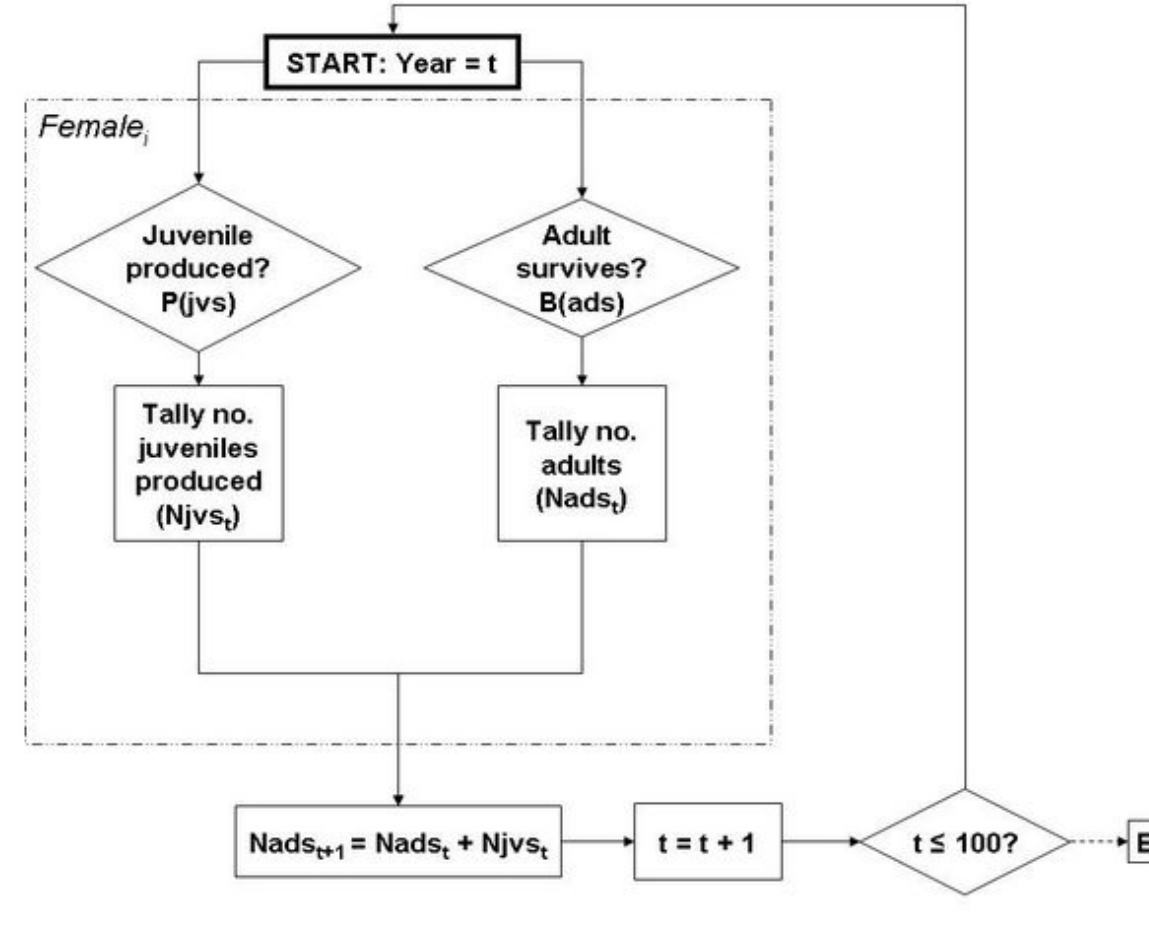
Fig. 1. Flow diagram showing algorithm used for each iteration in stochastic, female-focused, stage- based, discrete population viability analysis for large-bodied woodpeckers. Probabilities are abbreviated as follows: P(jvs) = number of juveniles produced/adult, which is drawn from the Poisson distribution; B(ads) = survival outcome for each adult female, which is drawn from a Bernoulli distribution. Solid arrows indicate either “yes” or forward progression of the model. Dashed arrow indicates “no.” Processes inside the dotted box are repeated for each adult female and each year in the model